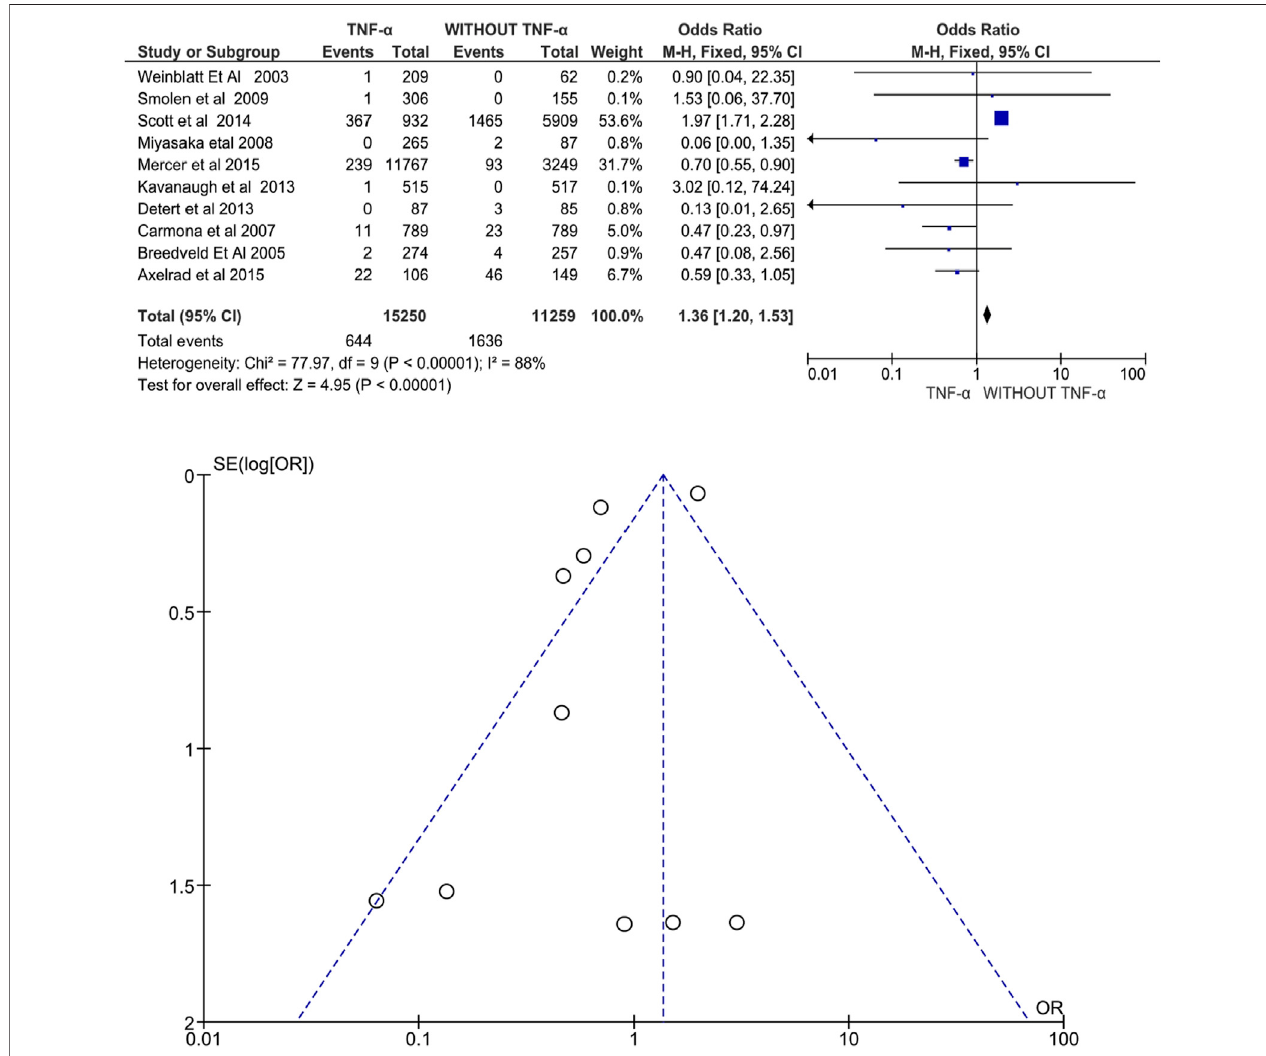
FIGURE 3 | (A) Forest plot for serious infection after treatment with anti-TNF α agents versus control group (without anti-TNF α agents) using a random-effects model. Odds ratios and 95% con fi dence intervals are shown (B) Funnel plot for assessment of publication bias.